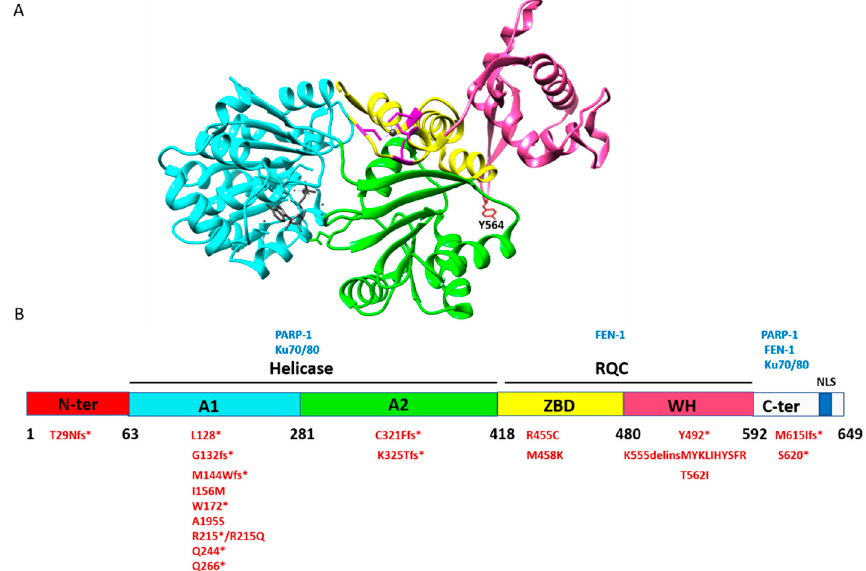
Figure 1. Human RECQ1 protein. ( A ) Crystal structure of RECQ1 (49–616) in the presence of MgCl 2 , ATP γ S, and DNA (PDB: 2V1X). A1 (amino acids 63–281; cyan color), A2 (amino acids 282–418; green color), ZBD (amino acids 418–480; yellow color), and WH (amino acids 481–592; pink color). The conserved cysteine residues C453, C471, C475, and C478, shown by magenta color, are coordinated with Zinc ion (dim gray). The Y564 in β hairpin is shown by red color. The crystal structure contains Mg-ADP, but the DNA is missing. ( B ) Schematic of the RECQ1 domain structure. Breast cancer risk associated variants and the RECQ1 domains known to interact with various proteins are indicated. Protein interaction between RECQ1 and PARP-1 is mediated primarily through the helicase domain and C-terminus, FEN-1 interacts with the RQC domain and C-terminus, and the interaction with Ku70 / 80 is mediated via the RECQ1 C-terminus, with some contribution from the helicase domain. NLS—nuclear localization sequence.